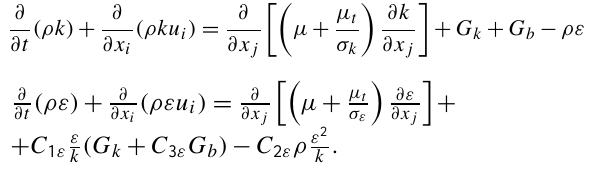
Two main configurations are considered, when the inter- val under the diffuser is empty or filled by removable bottom sediments. The first case corresponds to the nominal config- uration, the second one would simulate the risk of sediment accumulation under the diffuser due to alternate semi-diurnal tidal currents (the pipe behaving as a barrier). For both cases we carry out the numerical simulation of the pollution of coastal waters from a point source which corresponds to one port (circular opening with a diameter d ) of the ocean outfall diffuser. The diffuser pipe has a circular section of diameter d at the height L from the seabed. We consider a buoyant ef- fluent which is discharged vertically at average velocity.